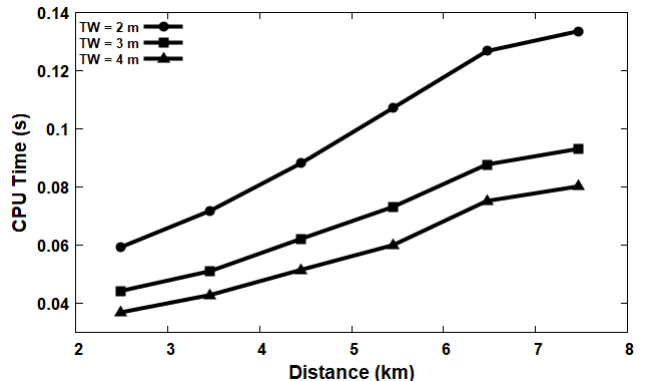
Figure 10. CPU time for different